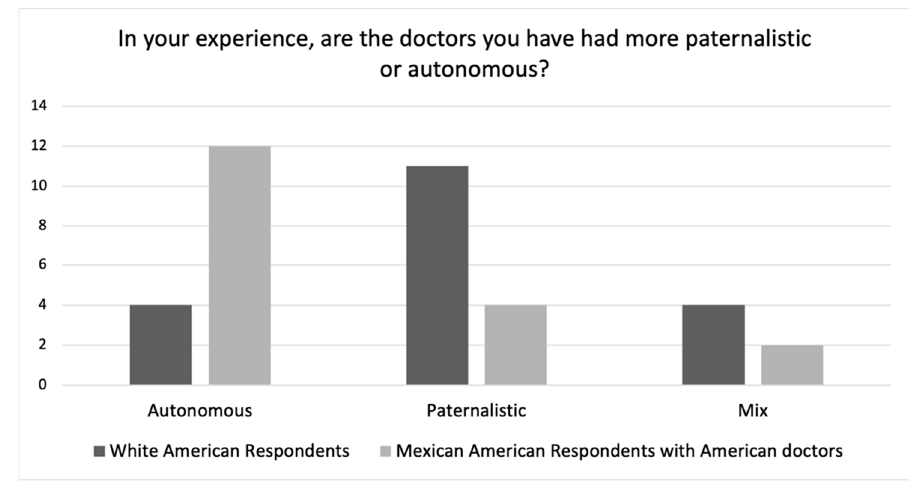
Figure 5. Mexican American vs. White American Respondents’ Experiences.